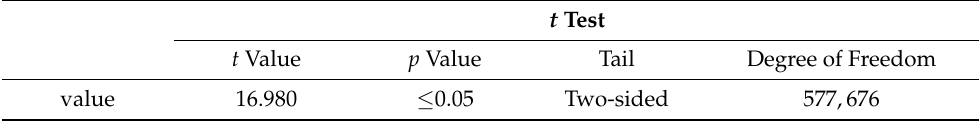
Table 4. Results of t -test of the MAE from the optimized MLP and the baseline model.